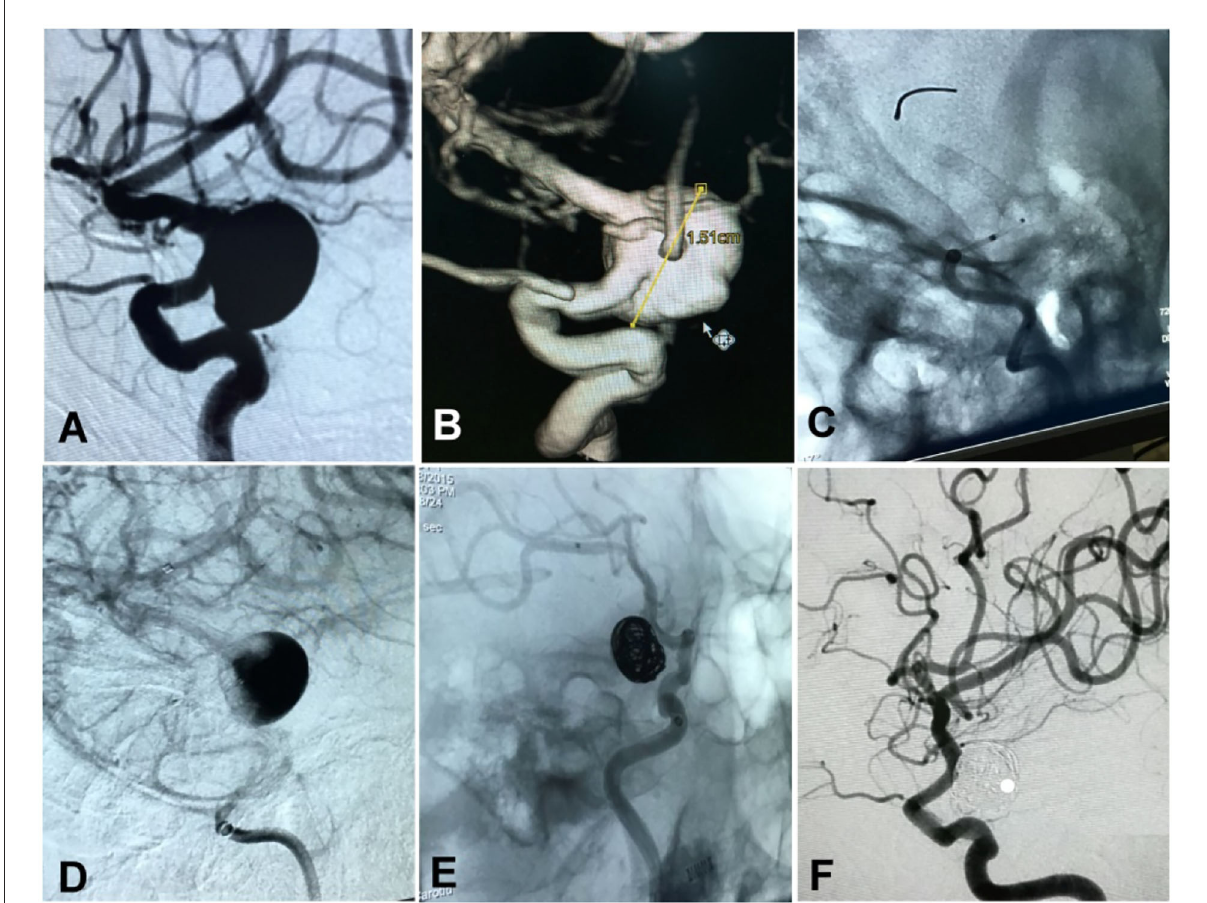
FIGURE3 A woman in her 50’s had a ruptured aneurysm (Hunt–Hess grade II) measuring 15 × 17mm at the posterior communicating segment of the internal carotid artery treated with a Pipeline embolization device plus adjunctive coiling. (A,B) The aneurysm is shown. (C) A Pipeline embolization device of 3.5 × 25mm was deployed. (D) After deployment of the stent, blood flow into the aneurysm cavity was significantly reduced. (E) The aneurysm was loosely occluded at the end of embolization. (F) At 25-month follow-up, the aneurysm was completely